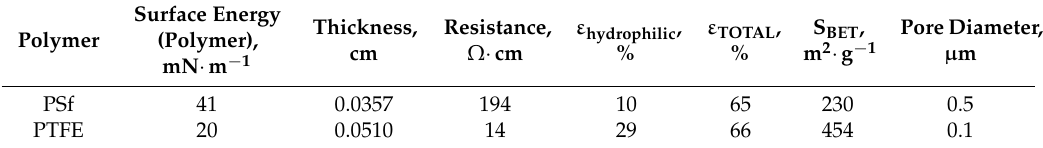
Table 1. Influence of polymer binder and fabrication method on the properties of the active layer (composition 80 wt % C:20 wt %